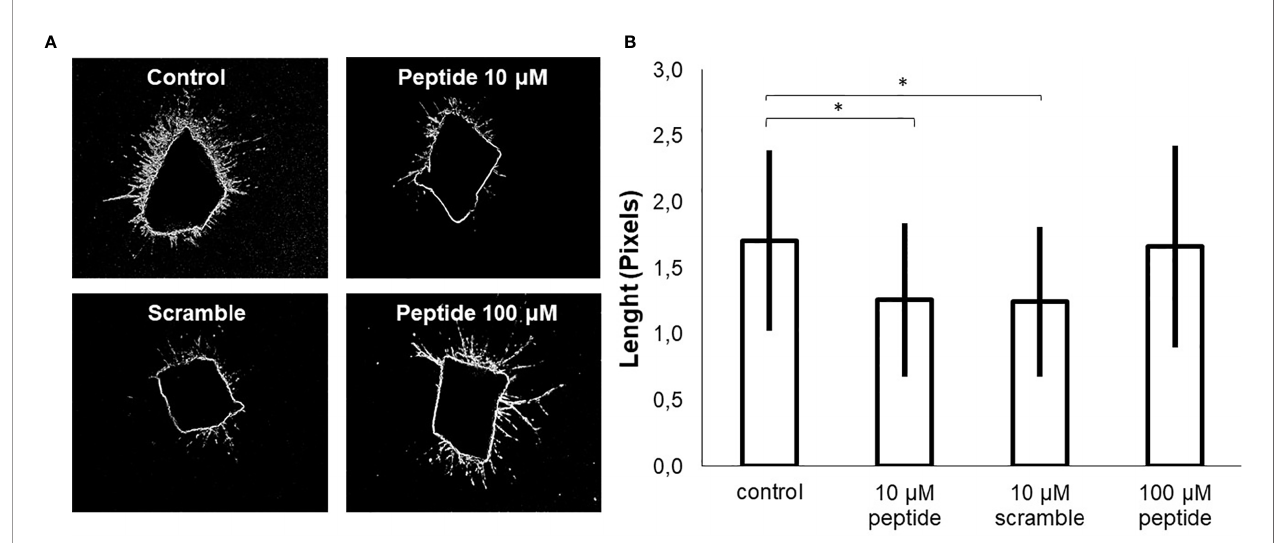
FIGURE 5 | Ex vivo angiogenesis assay. Sixteen rings of mouse aortas were collected and cultured in culture plates containing Matrigel for seven days, (A) aorta ring cultured in the absence of peptide (control); aorta ring cultured in the presence of HS-binding peptide (10 µM or 100 µM) and aorta ring cultured in the presence of scrambled peptide (10 µM). (B) The area of the formed blood vessels was analyzed using ImageJ software. The values represent means and standard deviations the area reached by the blood vessels formed from the aorta. *p < 0.05 (ANOVA). The HS-binding peptide decreased blood formation from the